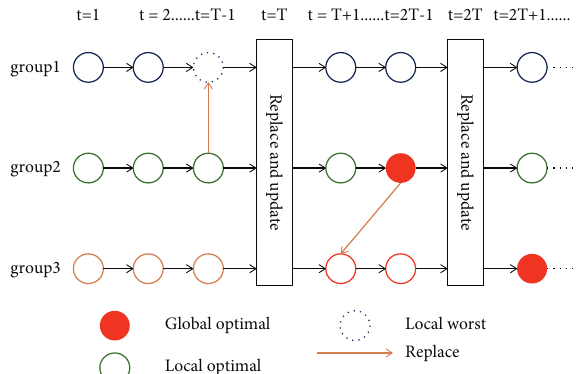
Figure 1: Parallel communication strategy process.